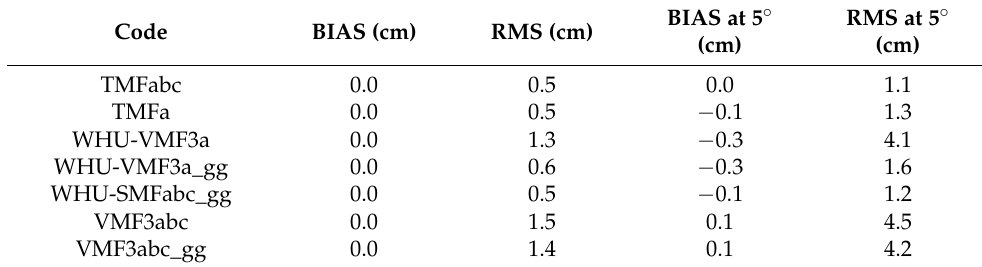
Table 7. Accuracy of MF-derived wet